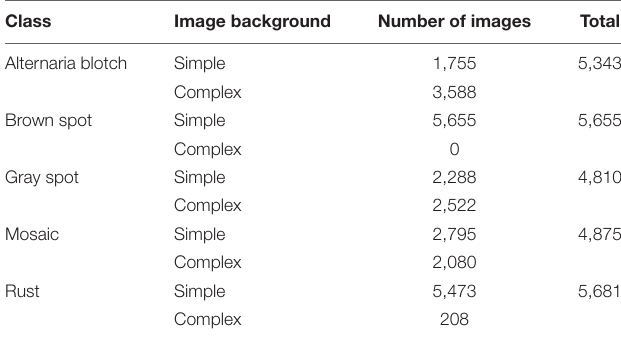
TABLE 1 | Apple leaf disease classes and the amount of data in different